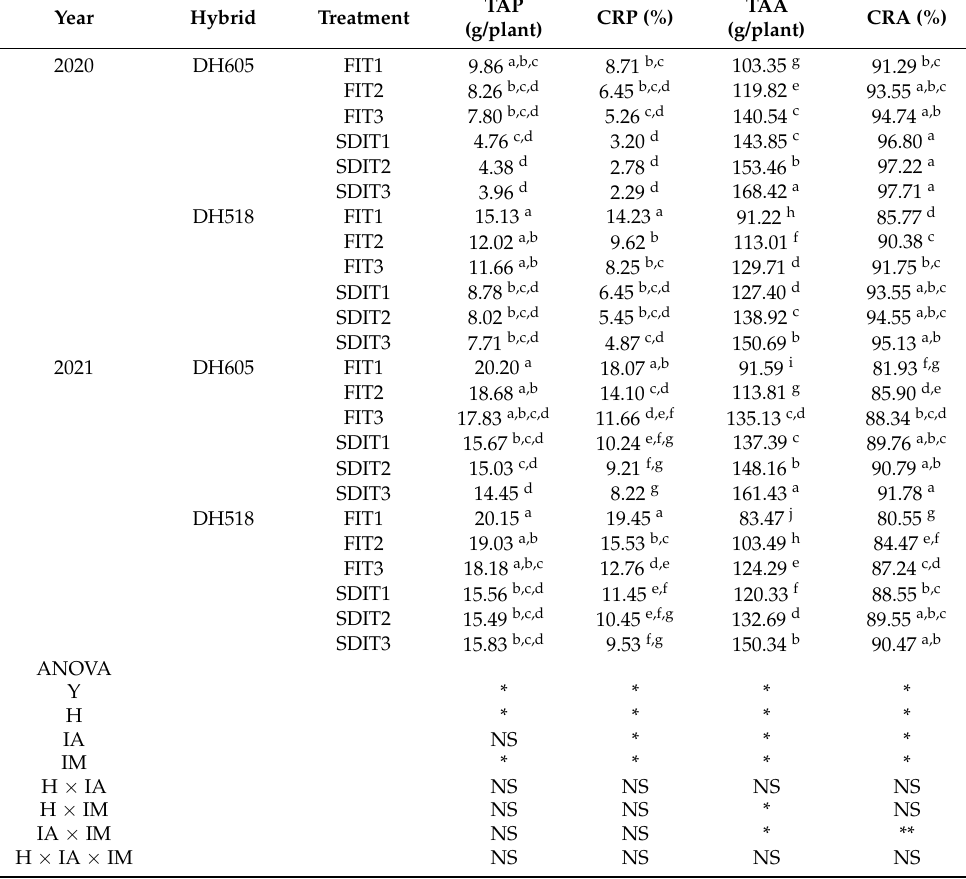
Table 5. Effects of different irrigation treatments on dry matter distribution and PAT/PT for two corn hybrids differing in